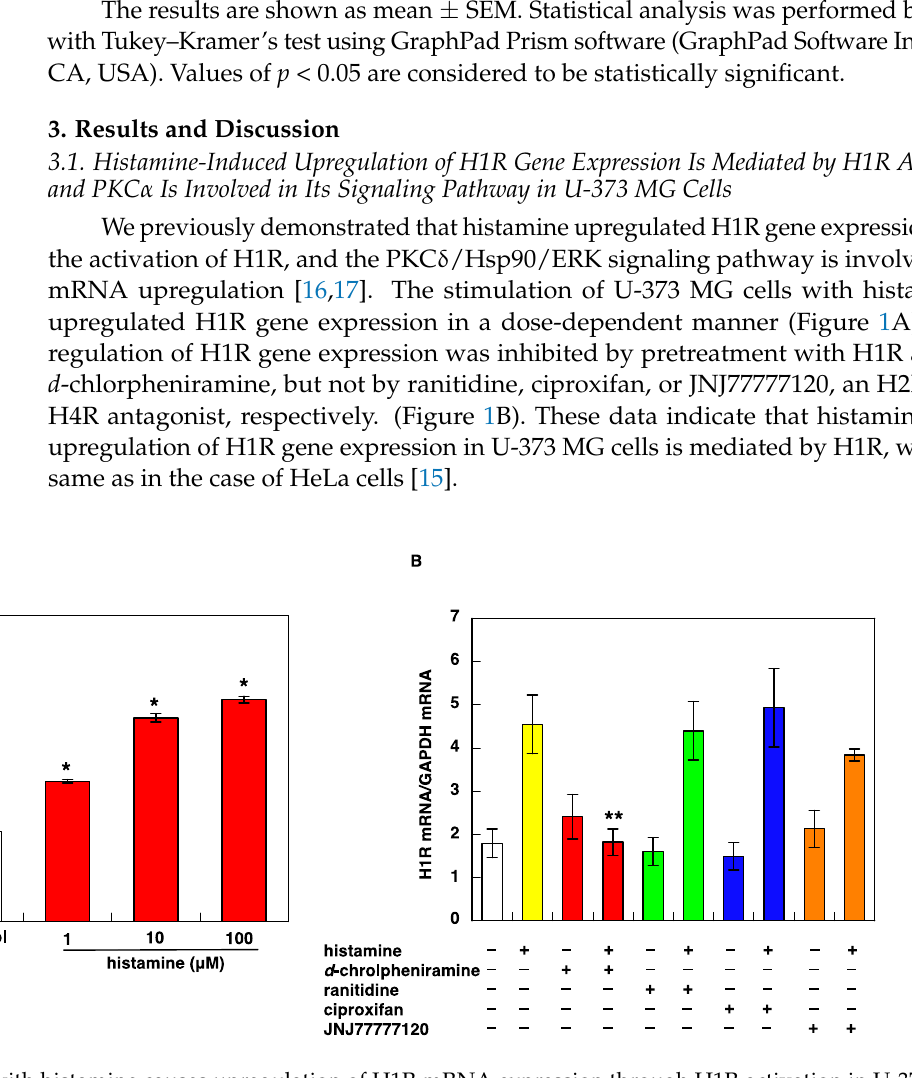
Figure 2. Effect of PKC isozyme-selective inhibitors on histamine-induced upregulation of H1R gene expression in U-373 MG cells. Isozyme-selective PKC inhibitors were treated 1 h before stimulation with 100 μ M histamine. After stimulation, total RNA was isolated, and the H1R mRNA level was 00.51 1.5 2